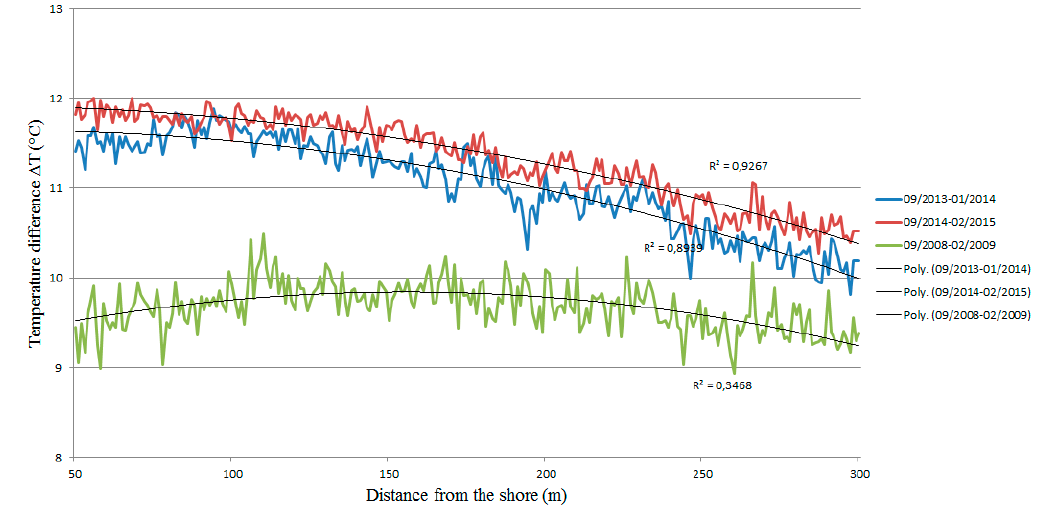
Figure 11. The between-month difference in sediment temperatures for the months with the highest and the lowest temperature values in the periods 2008–2009, 2013-2014 and 2014-2015. The polynomials of second degree are drawn as trend lines.